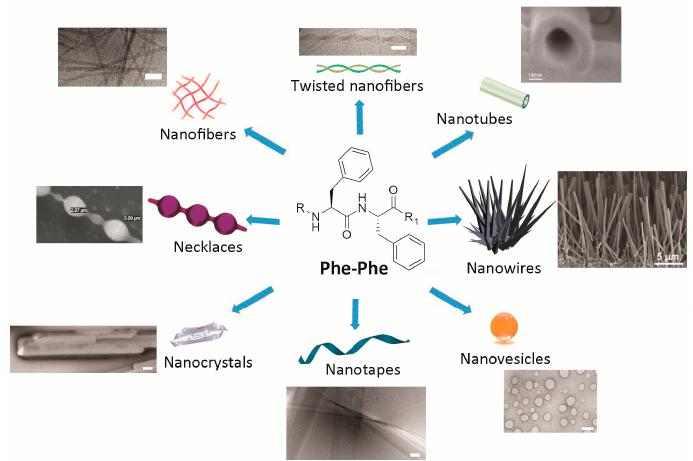
Figure 1. Simple compounds bearing the Phe-Phe motif self-assemble into diverse nanomorphologies. Scale bars = 100 nm, unless otherwise stated on the image. Adapted with permission from: refs. [13,55] © 2012 American Chemical Society; refs. [36,54,56] with kind permission of the Royal Society of Chemistry; ref. [39] with permission from Wiley © 2008 WILEY-VCH Verlag GmbH & Co. KGaA; and with permission from ref. [57] © 2006 Nature Publishing